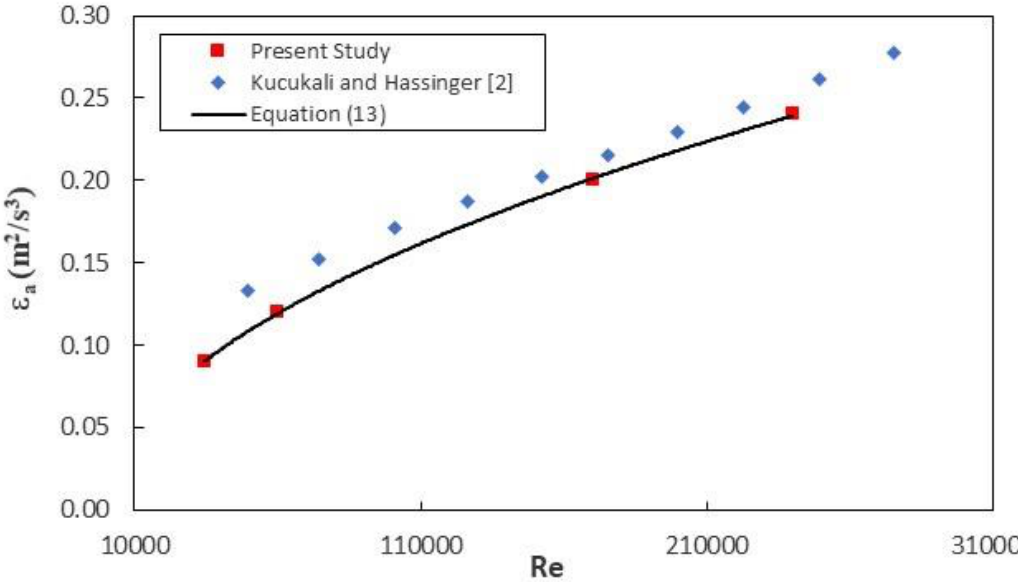
Figure 6. Discharge rating curve of the Incirli brush fish pass.